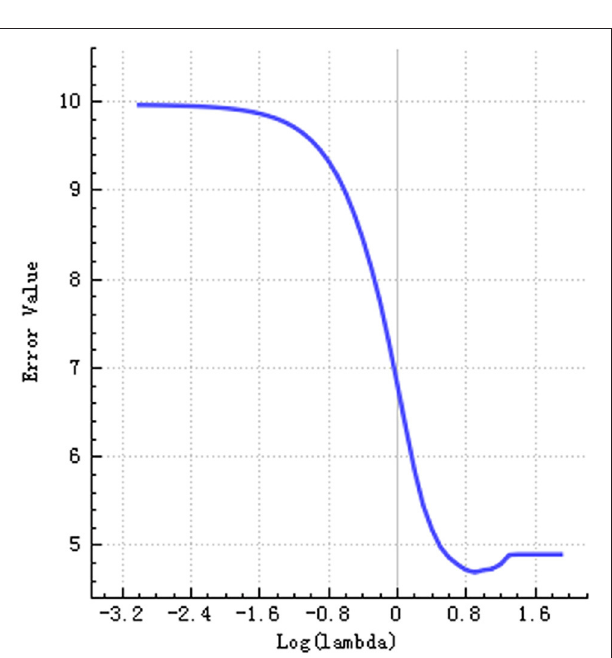
FIGURE 2 | Graph shows